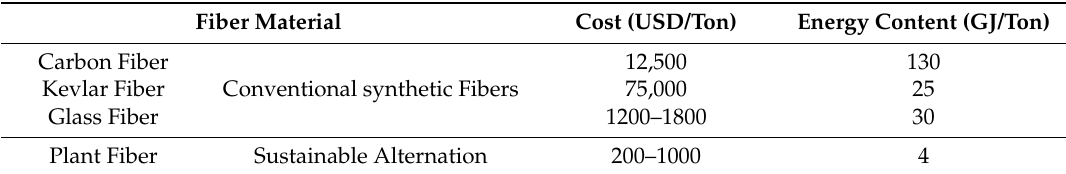
Table 1. Comparison of specific properties and cost of conventional synthetic fiber and natural plant fiber